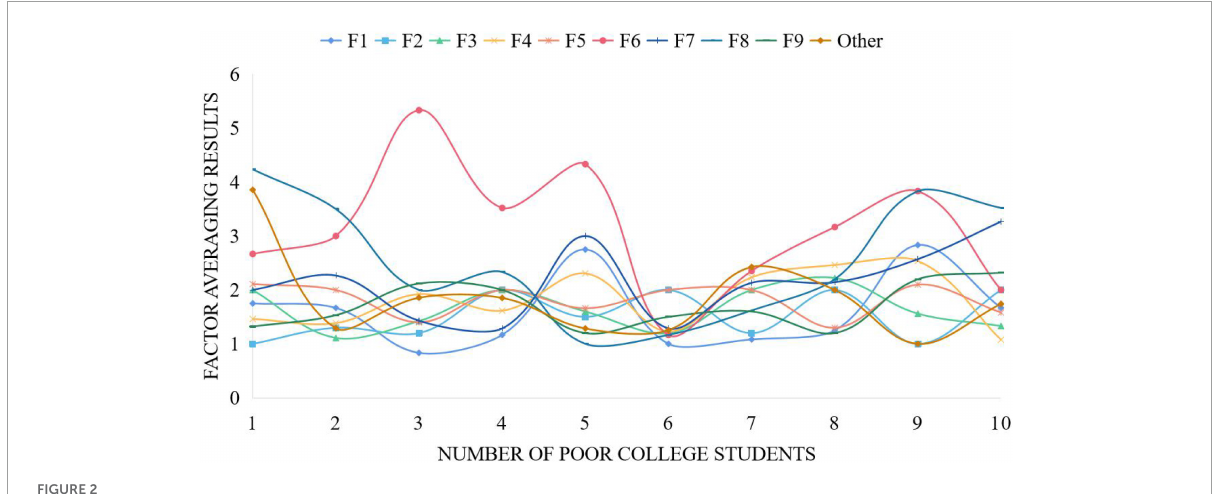
FIGURE2 Some sample data processing